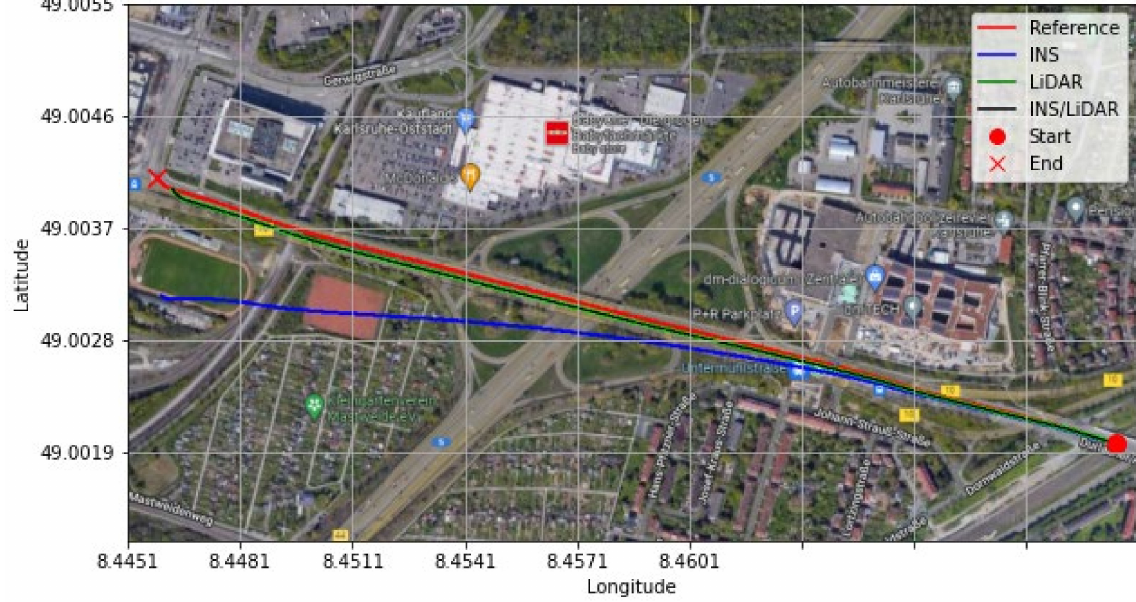
Figure 15. D-101—complete GNNS signal outage: comparison of